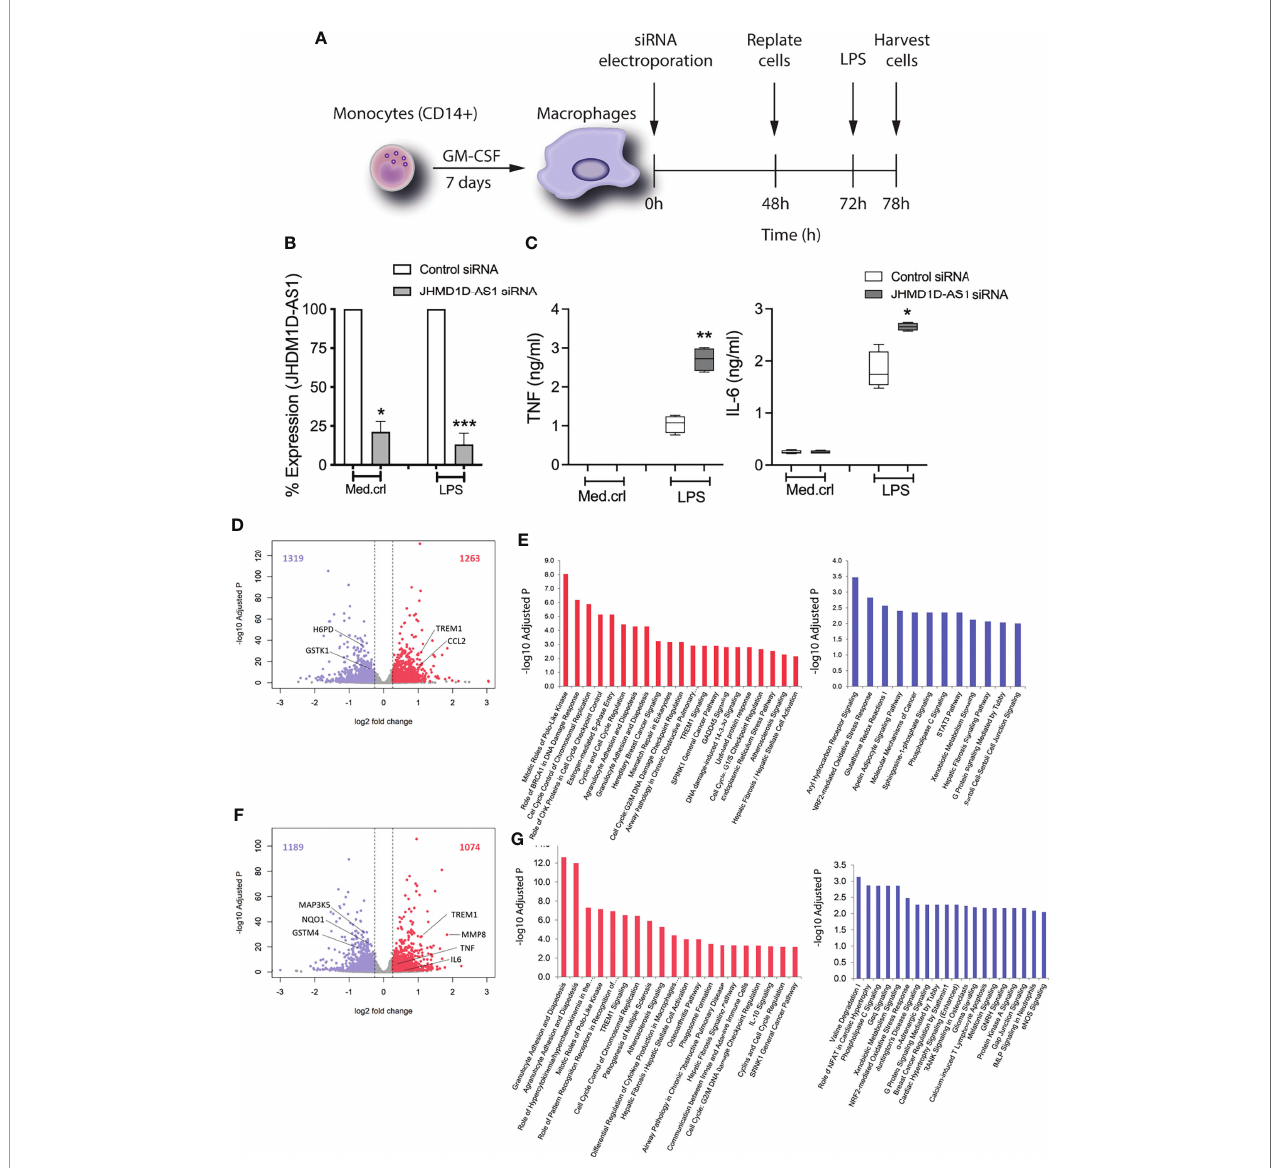
FIGURE 2 | JHDM1D-AS1 de fi ciency leads to increased pro-in fl ammatory gene responses in human monocyte-derived macrophages upon LPS exposure. The expression of JHDM1D-AS1 was modi fi ed in monocyte-derived macrophages using siRNA electroporation. (A) Schematic overview of the experimental setup. (B) JHDM1D-AS1 expression (analyzed by RT-qPCR) in JHDM1D-AS1 – de fi cient or control cells, showing a 70% – 80% reduction in JHDM1D-AS1 levels in the former. (C) The secreted levels of TNF and IL-6 were determined in supernatants using ELISA. Error bars indicate SD (B) , whereas the boxes (C) extend from the 25th to 75th percentiles, the whiskers range from minimum to maximum, and the horizontal line indicates the median. Unpaired student ’ s t-test on raw data (B) and paired student ’ s t-tests (C) were performed respectively for the indicated comparisons. *p < 0.05; **p < 0.01; ***p < 0.001. (D) Volcano plot illustrating basal levels of gene expression signi fi cantly altered due to JHDM1D-AS1 de fi ciency (relative to control cells). Red denotes elevated expression (adjusted p < 0.05, fold change ≥ 1.5); blue denotes reduced expression (adjusted p < 0.05, fold change ≤ − 1.5). (E) Ingenuity pathway analysis of the signi fi cantly altered RNA transcripts at baseline. (F) Volcano plot depicting signi fi cantly altered genes, and (G) ingenuity pathways analysis of those signi fi cant transcripts in JHDM1D-AS1 – de fi cient cells, relative to control cells, after exposure to LPS (100 ng/ml). Red denotes elevated expression (adjusted p < 0.05, fold change ≥ 1.5); blue denotes reduced expression (adjusted p < 0.05, fold change ≤ −